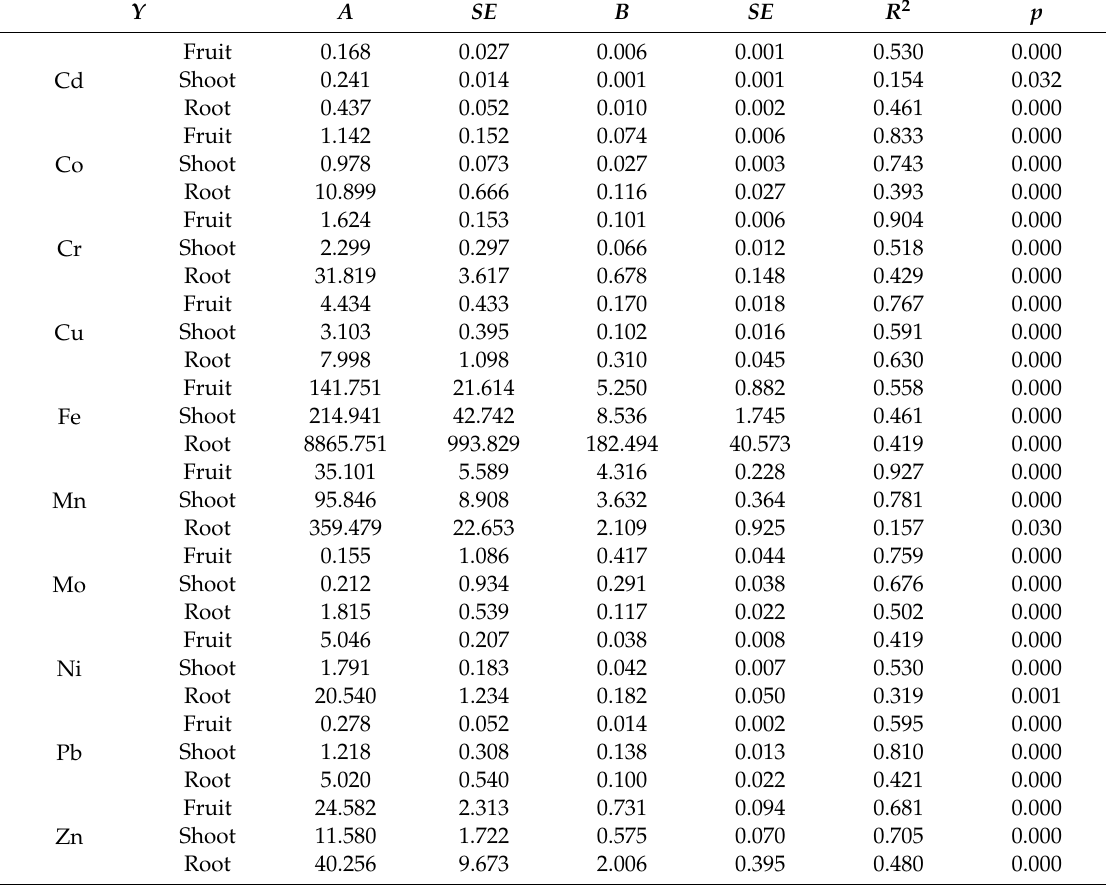
Table 4. Linear regression equations of the form y = a + bx , where y represents the heavy metal concentration (mg / kg) in Pisum sativum tissue harvested after 57 days, and x is the sewage sludge amendment rate (g /